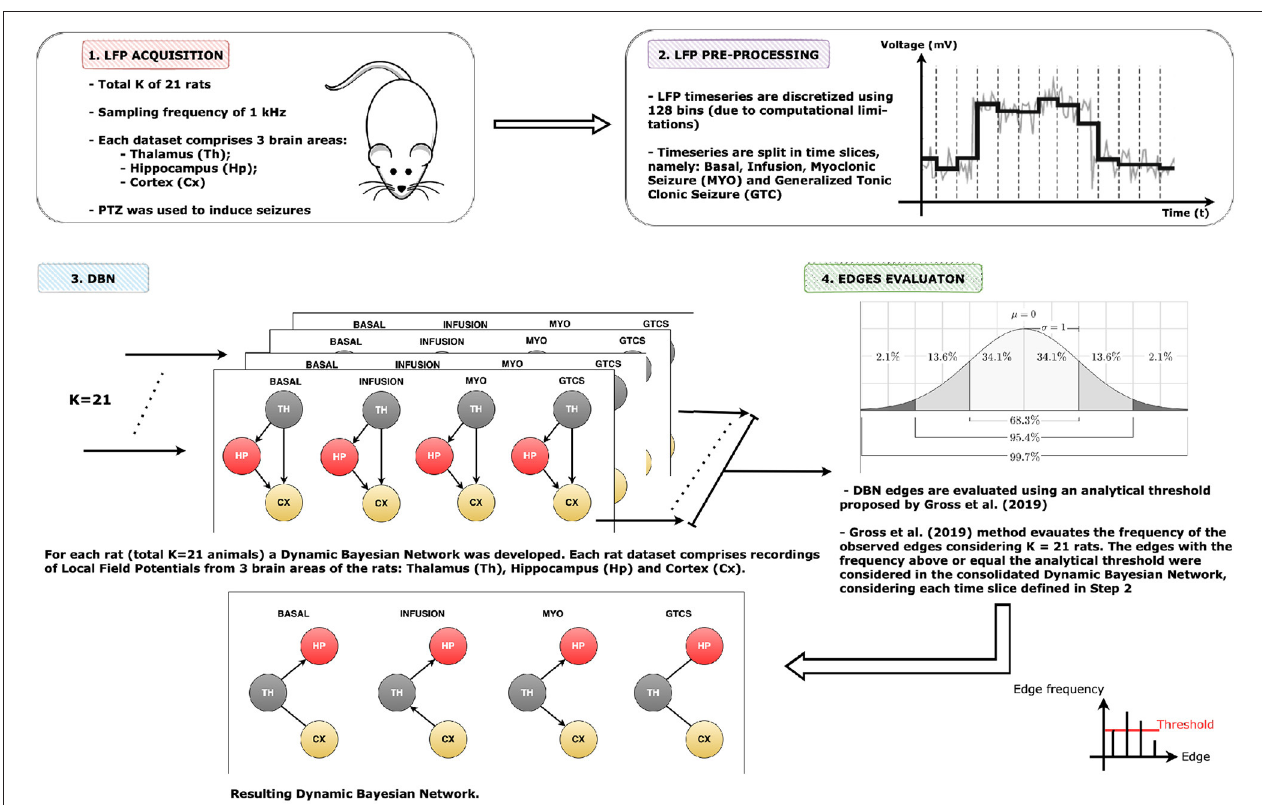
FIGURE 3 | Applied methodology. The initial step is the LFP data acquisition from rats involved in the pre-clinical trial. After discretizing and splitting into time slices, the following point-in-time was depicted: basal state, PTZ infusion, myoclonic seizure (MYO) and generalized tonic clonic seizure (GTCS). The third step involved using the DBN algorithm to observe the functional connectivity among time slices during the temporal evolution of rats, i.e., from basal state until GTCS. The arcs from developed Dynamic Bayesian Networks are evaluated using the analytical threshold model proposed by Gross et al. (2018) described in full detail in Gross et al.